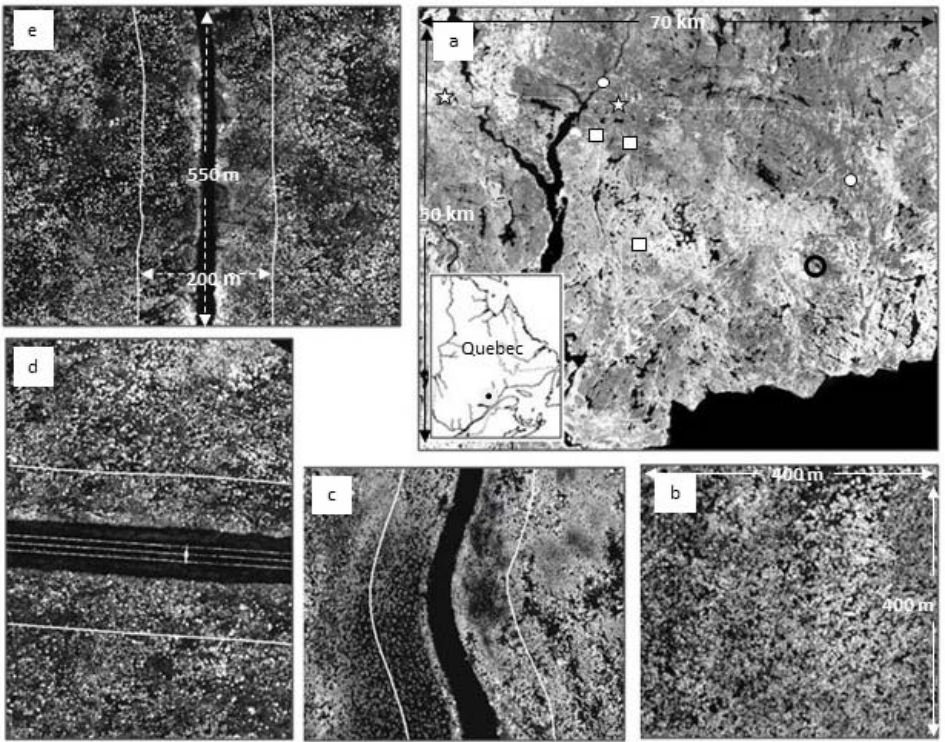
Figure 1. Location of the study area. ( a ) Location of the selected linear openings overlaid on the 78 km × 70 km window showing the near ‐ infrared reflectance from the Landsat ‐ ETM sensor (on the image, the black tone refers to the water bodies; gradient of white to grey tones indicate exposed soils or recently cleared forest to matured forests; open black dotted circle: reference forest; star: powerlines; square box: roads); ( b ) CHM of the reference forest; ( c ) CHM of stream overlaid with 100 m buffer; ( d ) CHM of powerline overlaid with 100 m buffer; ( e ) CHM of road overlaid with 100 m buffer. CHM is a canopy height model, and increase in height is given by progressively lighter shades in all figures.